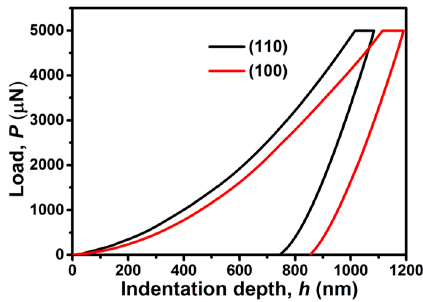
Figure 3. Representative load-indentation depth ( P - h ) curves of MAF-7 measured with a Berkovich tip normal to the (110) and (100) planes.